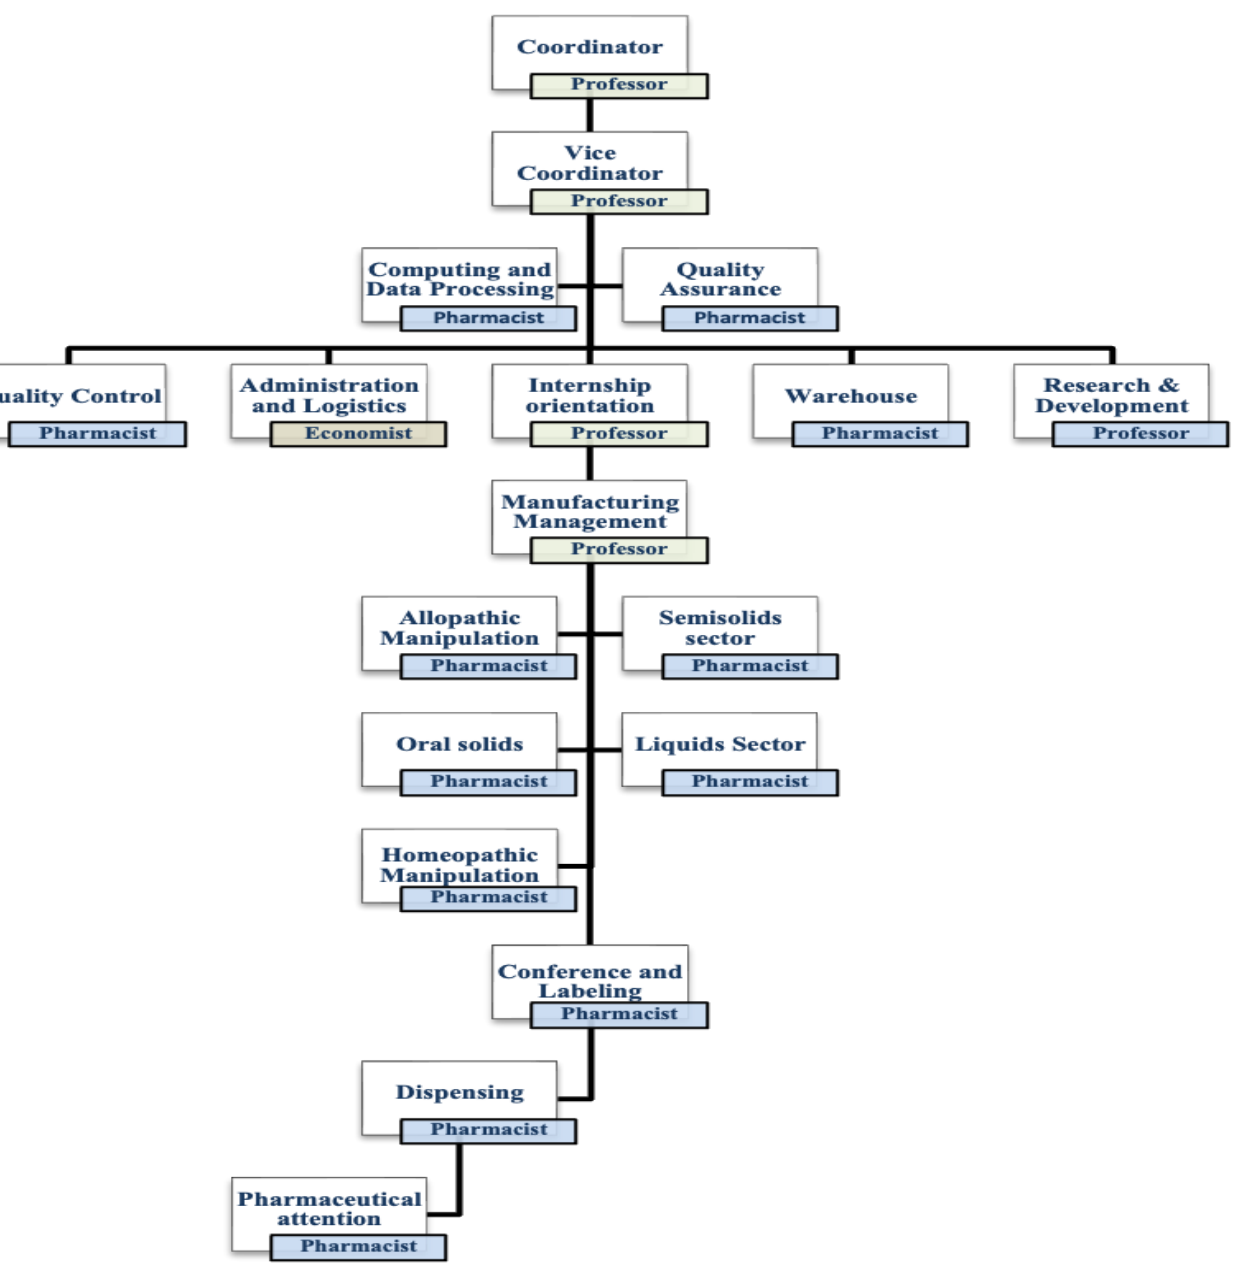
FIGURE 2 - FU-UFRJ organizational